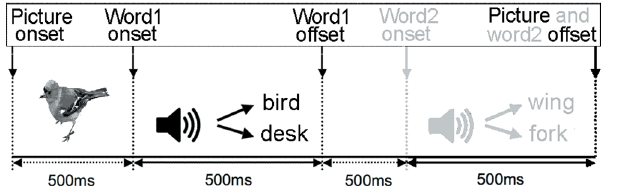
Fig 1. Sample trial. Sequence of events per trial, including timing, visual and auditory input. For the purpose of this study, only data from the picture and the first word were